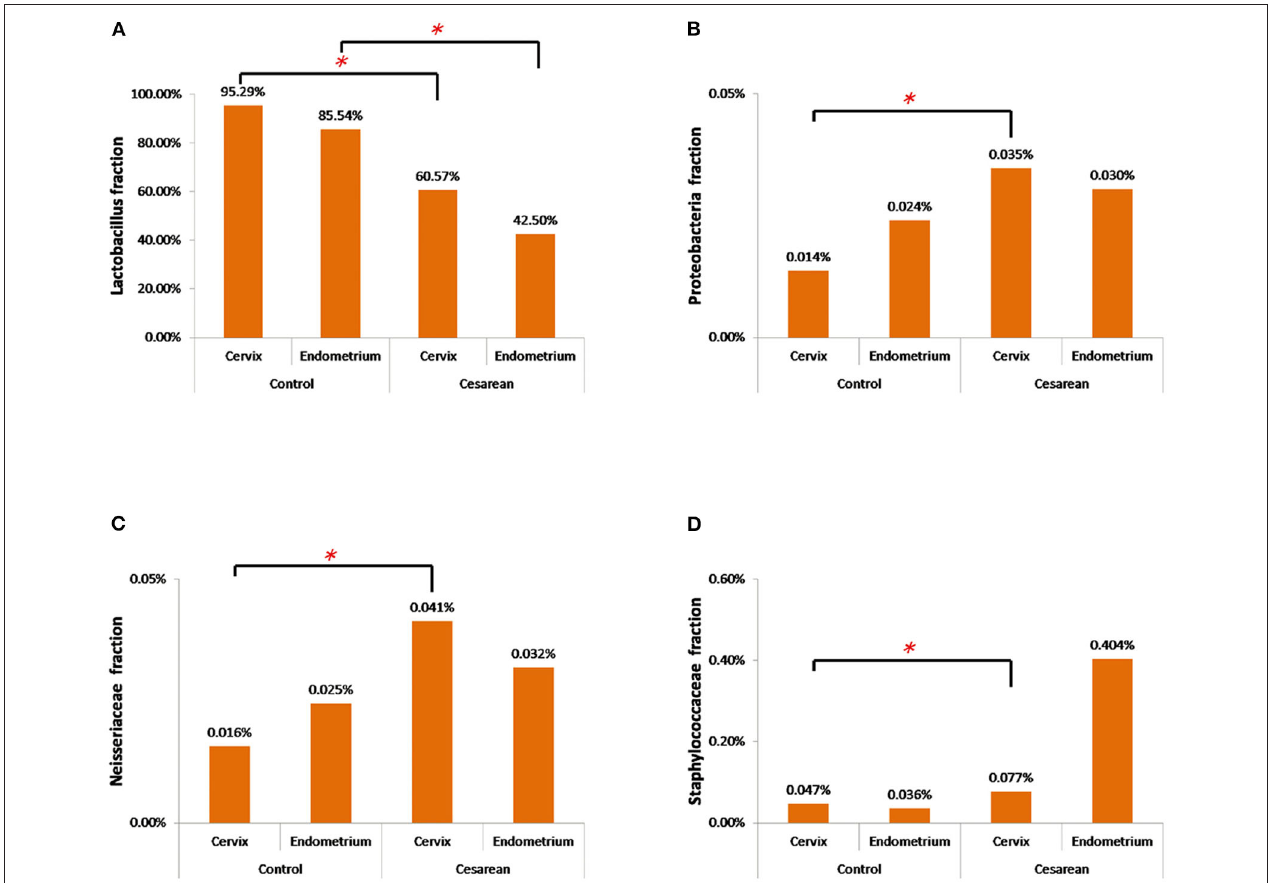
FIGURE 6 | The abundance of the four significantly changed bacterial flora. (A) The abundance of Lactobacillus in the cervix and endometrium in the control group was significantly higher than that in the cesarean section group. (B) Proteobacteria had the highest abundance in the cesarean section group, especially in the cervical tissue. (C) Neisseriaceae had the highest abundance in the cesarean section group, especially in the cervical tissue. (D) Staphylococcaceae only increased in the cesarean section endometrium group. * P < 0.05.